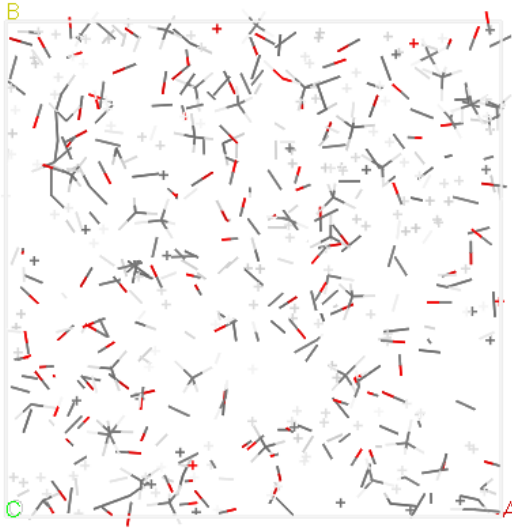
Figure 6. Model of 1000 atoms, 100% cured at 1250 K after 1.5 ns.